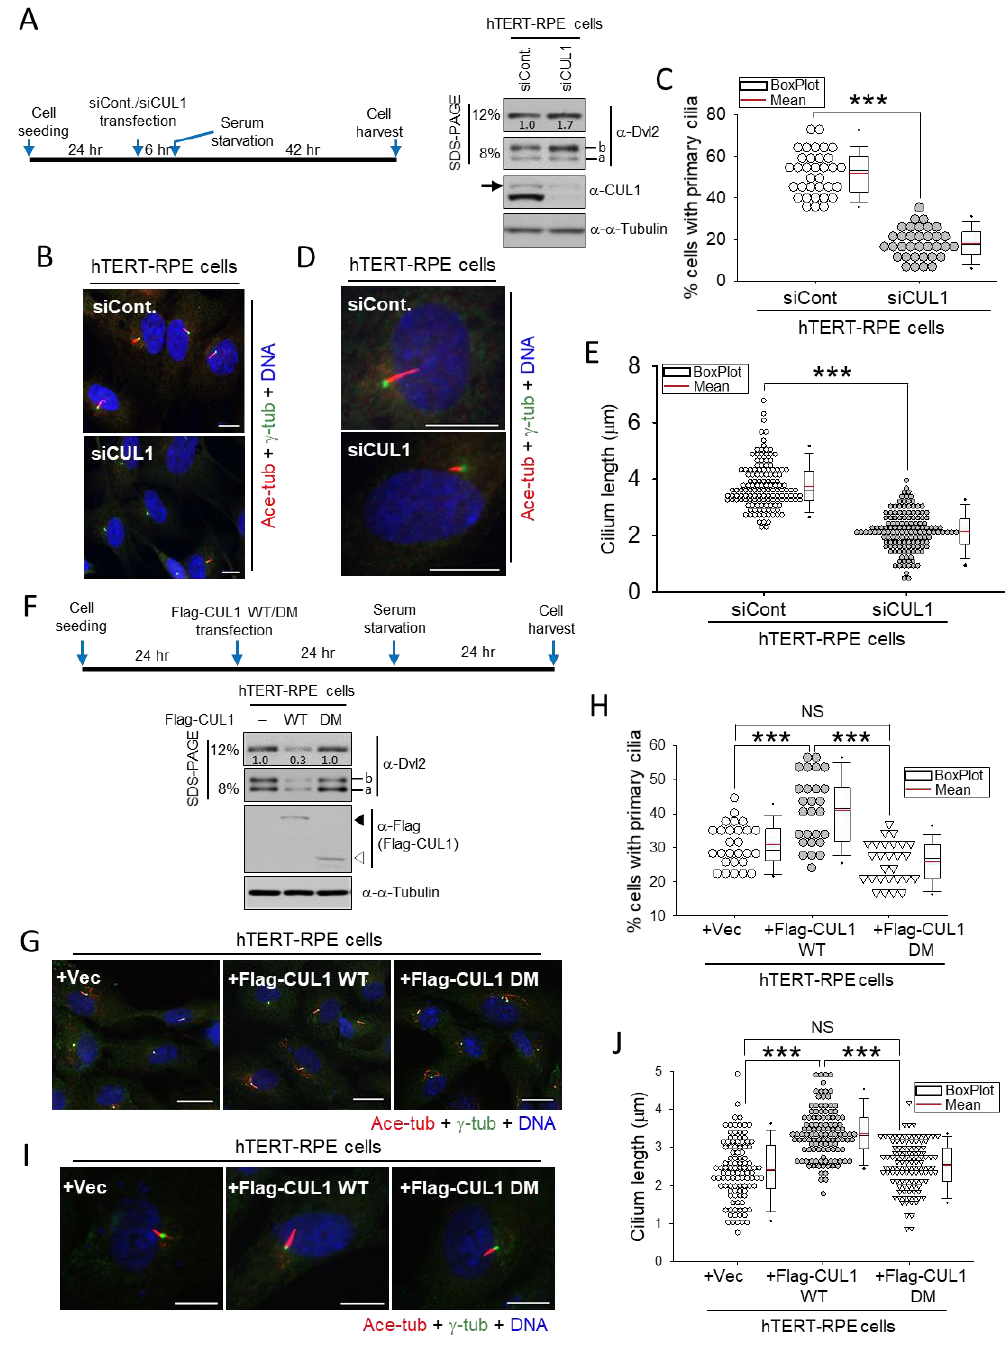
Figure 5. CUL1 promotes primary ciliogenesis. ( A ) hTERT-RPE cells transfected with either control (siCont.) or CUL1 siRNA (siCUL1) were serum-starved for 48 h according to the experimental schedule (left). The resulting cell lysates were subjected to immunoblotting analysis with the indicated antibodies (right). Immunoblotting with the anti- -tubulin anti-body represents the loading control of proteins. The band intensities of endogenous Dvl2 were measured using ImageJ and normalized to -tubulin, and the relative values are marked below the bands. The arrow indicates neddylated CUL1. Fast- and slow-migrating Dvl2 forms are referred to as the “a” and “b” forms, respectively. ( B – E ) The same conditioned cells as in ( A ) were subjected to immunostaining with anti-acetylated -tubulin and anti- -tubulin antibodies ( B , D ). Scale bar, 10 m. DNA was stained with DAPI. Cells containing primary cilia were counted ( B , C ), and the length of each primary cilium was measured ( D,E ). Each symbol in the dot-density graph represents a percentage (%) of ~40 cells ( C ). More than 100 cells were measured to determine the length of cilia ( E ). *** p < 0.001 (unpaired two-tailed t test). ( F ) hTERT-RPE cells transfected with control vector (-), pFlag-CUL1 WT (WT), or DM (DM) were serum-starved for 24 h according to the ex-